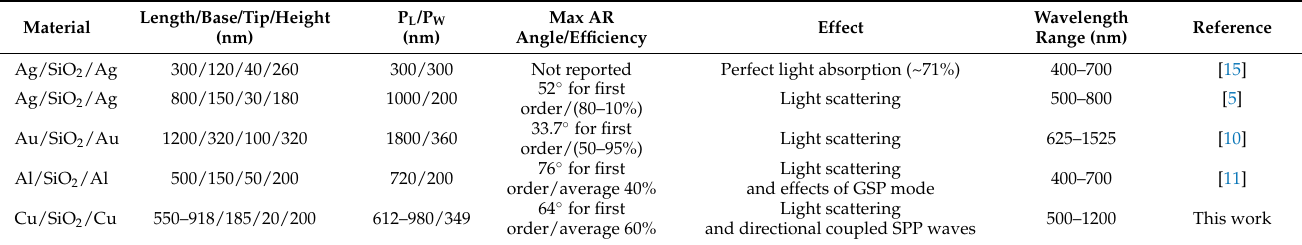
Table 1. Flat metal metasurfaces for trapezoid